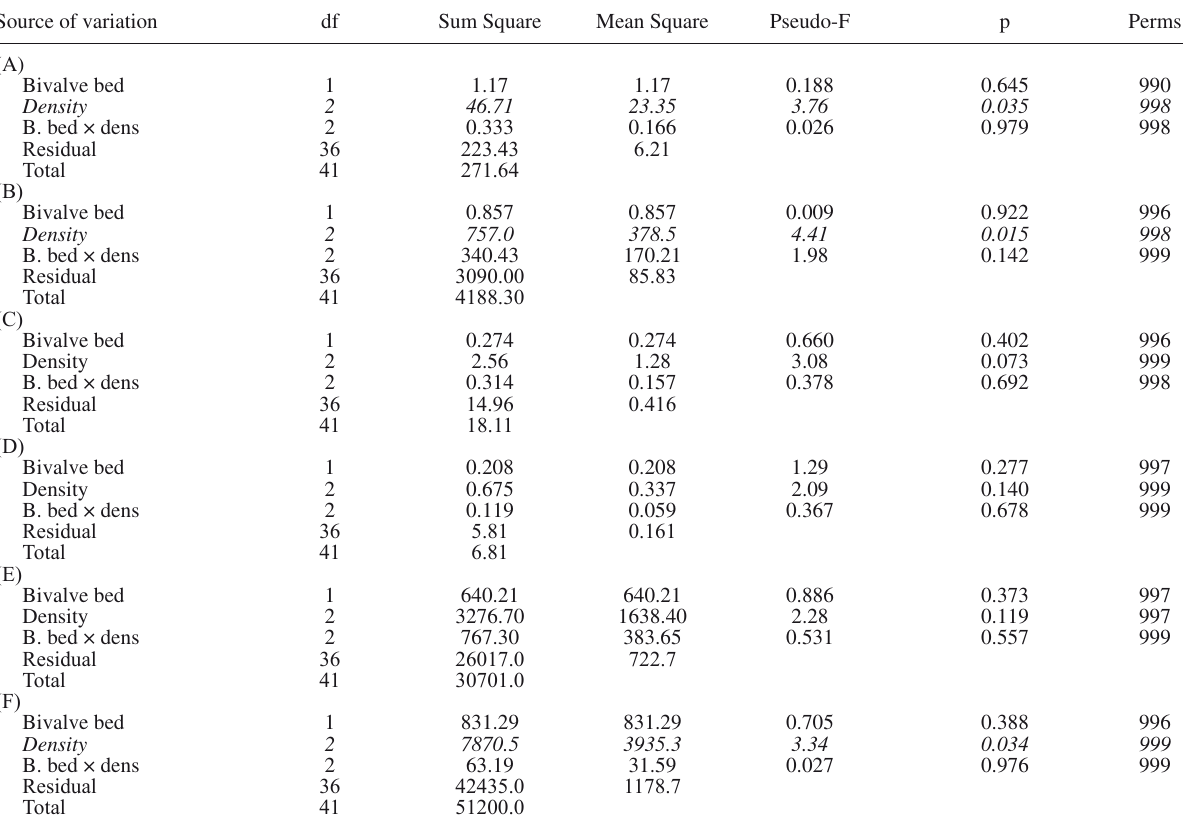
Table 2. – PERMANOVA for richness (A), abundance (B), Shannon diversity (C), evenness (D), taxonomic diversity (E), and taxonomic distinctness (F) of decapod crustaceans related to bivalve bed and density. Italics denote significant differences. Source of variation